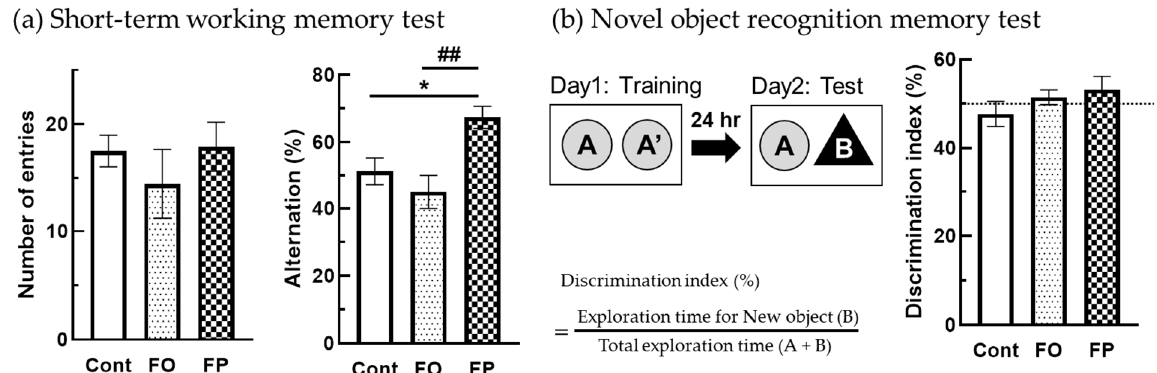
Figure 2. Fish protein (FP) feeding prevented loss of short-term memory in a senescence-accelerated mouse model at 6 months of age, better than the control diet or fish oil (FO) feeding. ( a ) Spontaneous activity and working memory in the Y-maze test. Total arm entries and alternation behavior were measured during an 8-min session. ( b ) Object recognition memory was measured in a novel object- based recognition test. A memory retention session was performed 24 h after the training session. The discrimination index was calculated as described. The dotted line represents 50% of discrimination index levels. All data are presented as the mean ± standard error of the mean ( n = 10 mice for control and FP, n = 7 for FO). * p < 0.05 vs. control diet group (Cont = control), ## p < 0.01 vs. FO group.